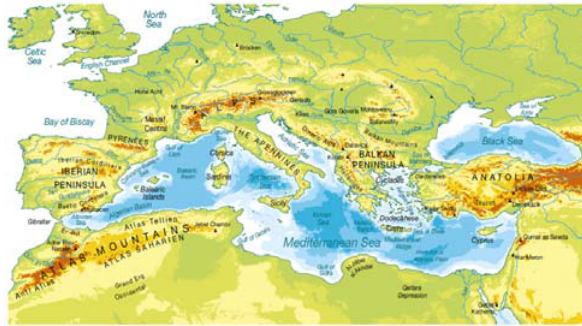
Figure 1: Map of the Mediterranean Sea Figure 2: Sarralà Coastal